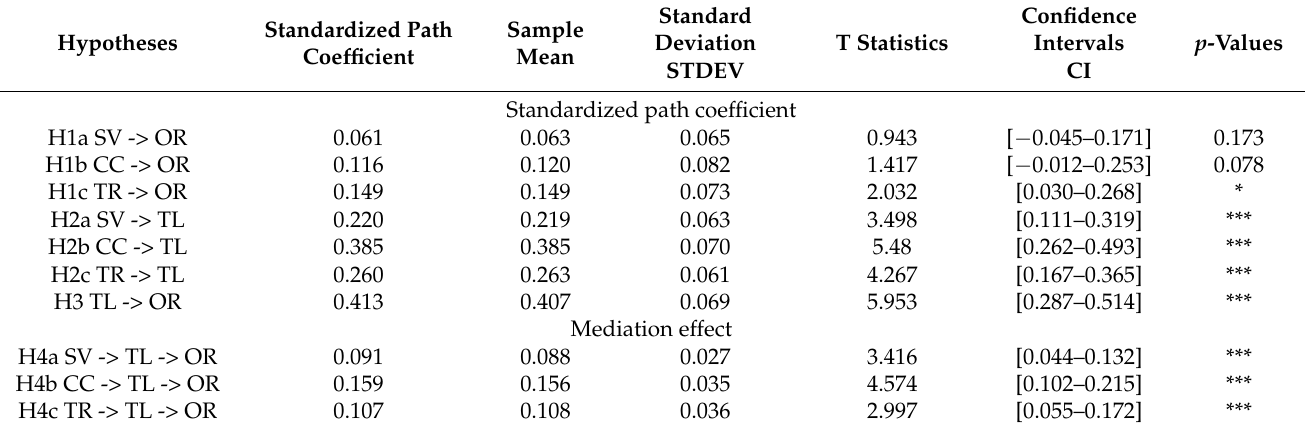
Table 2. Standardized path co-efficient and mediation effect of structural equation